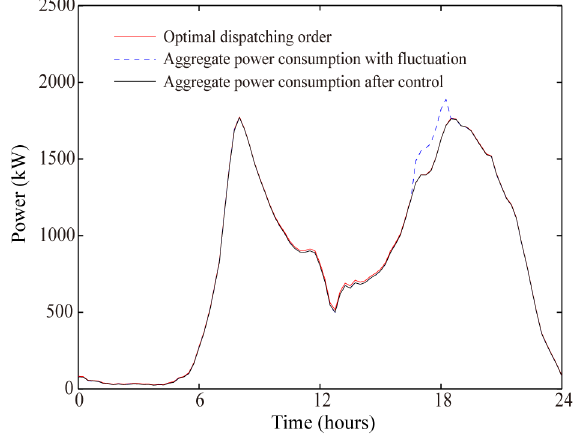
Figure 11. Actual aggregate power consumption of the distribution network.